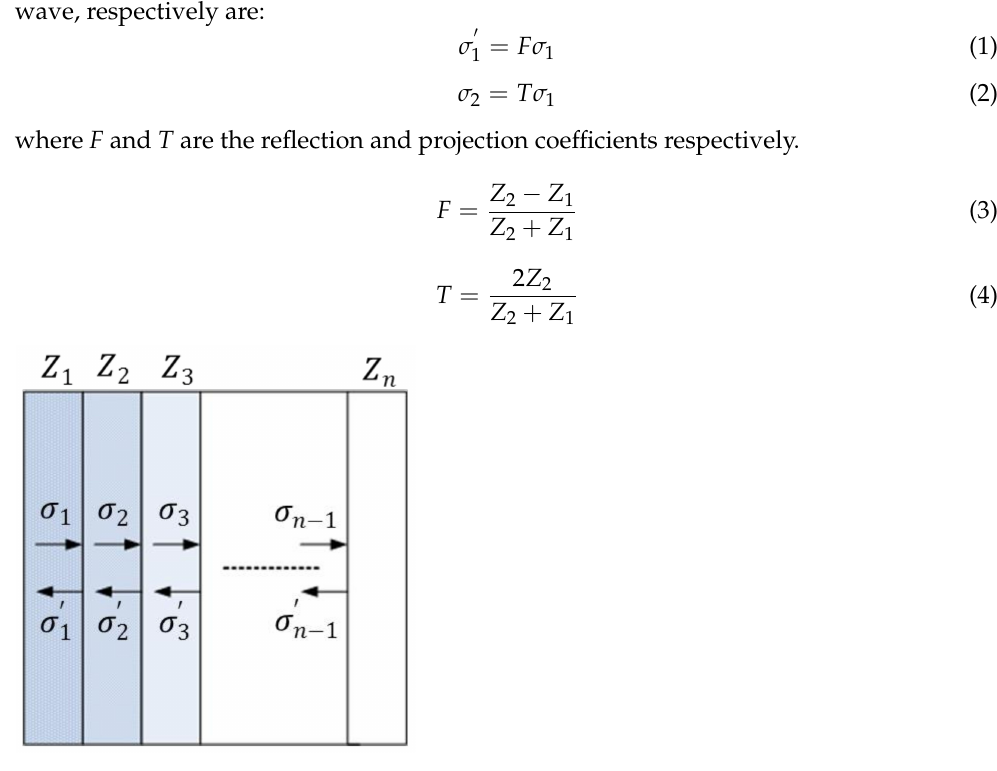
Figure 1. Reflection and transmission of shock wave in the wave-impedance gradient